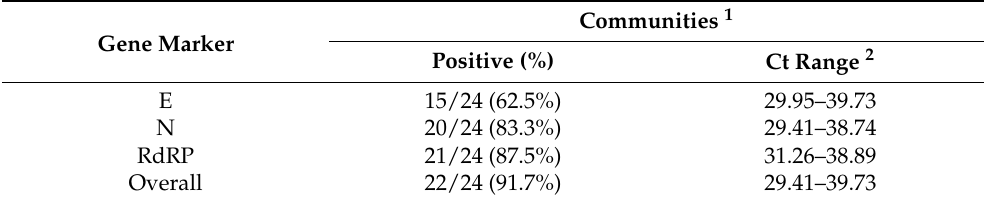
Table 2. SARS-CoV-2 detection in six communities of Davao City, Philippines from 9 November–12